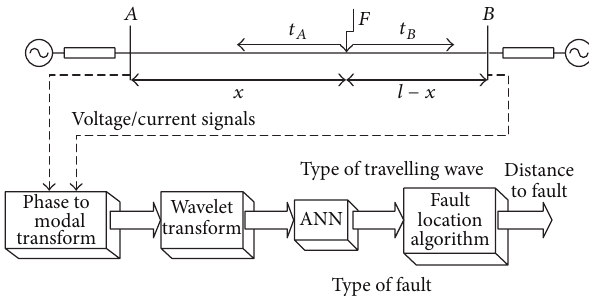
Figure 4: Illustration of a distorted voltage analysis using wavelet